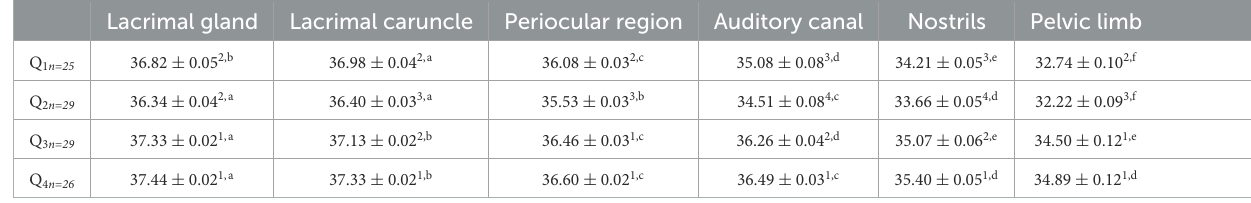
TABLE 7 Mean surface temperature of the different thermal windows ± standard error (SE) in water buffaloes ( n = 109) with different birth weights (Q 1 , 37.8–41.2kg; Q 2 , 41.3–46.3kg; Q 3 , 46.4–56.3kg; Q 4 ,